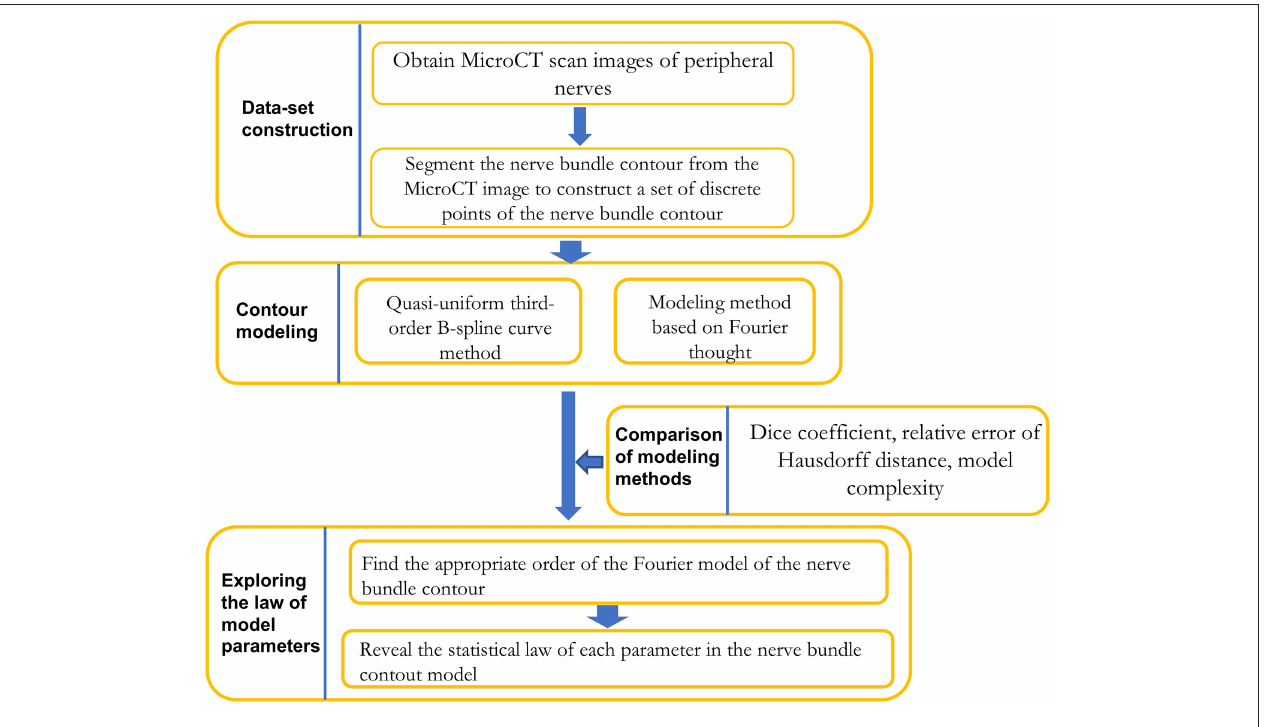
FIGURE 1 | Framework for contour modeling method research on nerve